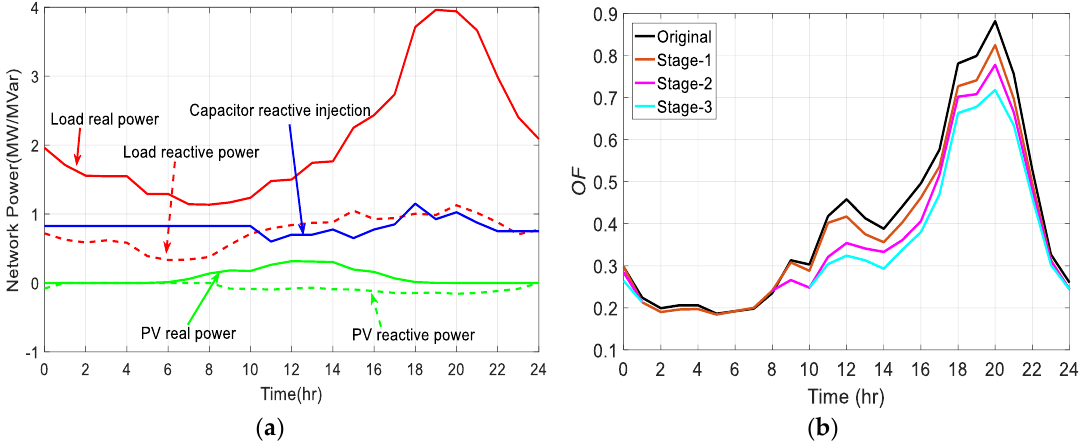
Figure 6. ( a ) Active and reactive power profiles of load, photovoltaic (PV) inverters and switched capacitors (SCs); ( b ) objective functions after control over 24 h.